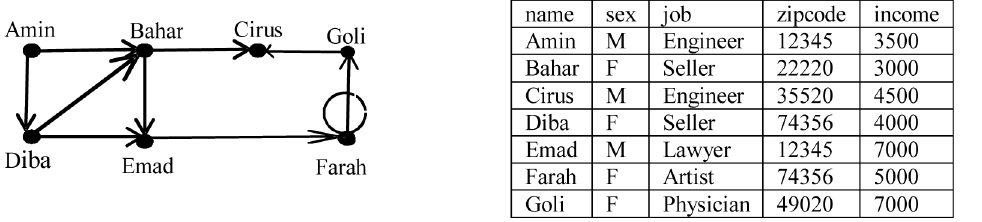
Fig 1. An example of money transformation